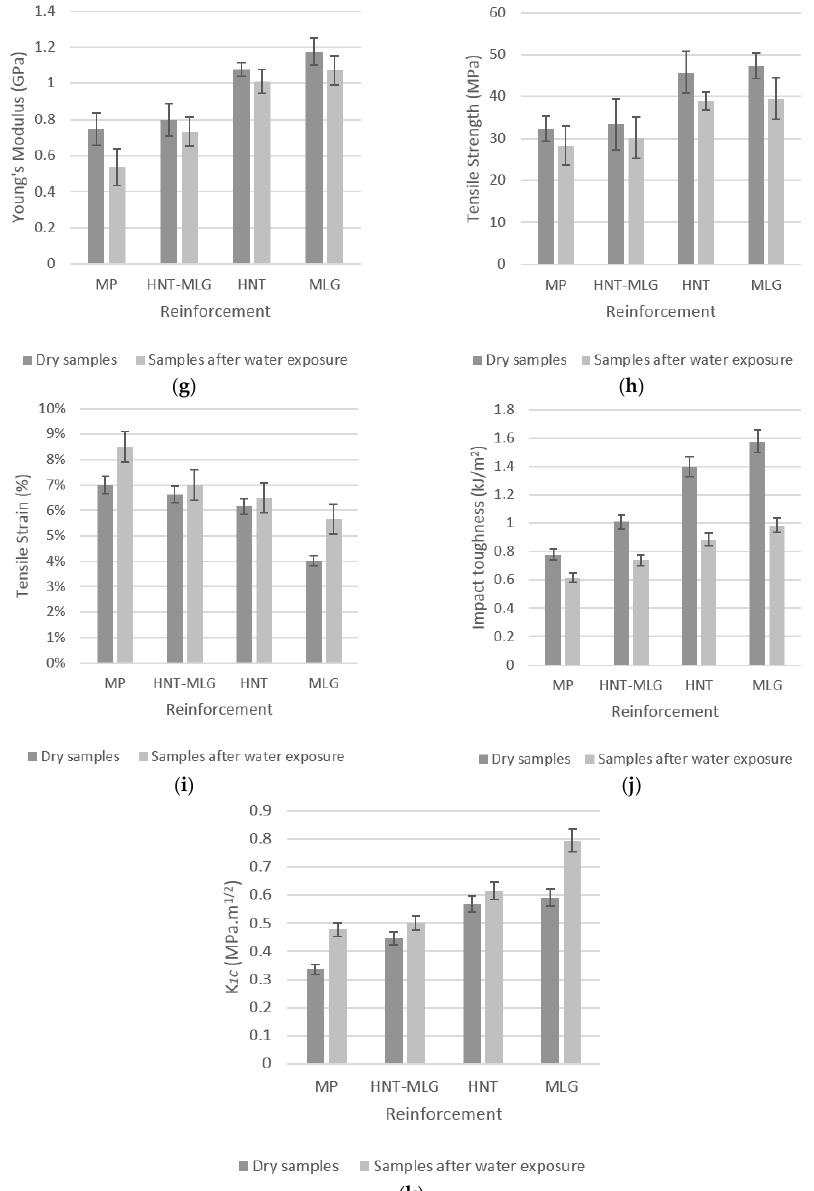
Figure 7. Mechanical properties of nanocomposites in dry conditions and after water exposure: ( a ) densification (%); ( b ) water absorption test (%); ( c ) microhardness (HV); ( d ) flexural modulus (MPa);